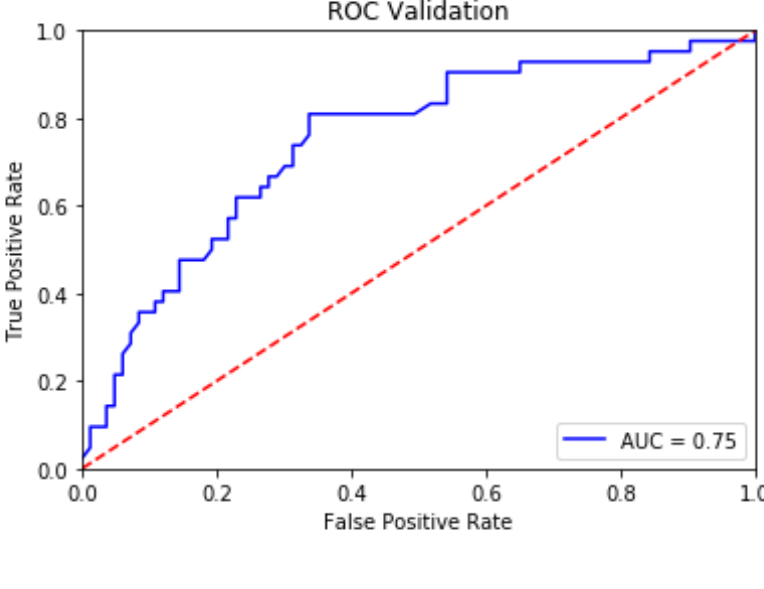
Figure 2. The receiver operating characteristic curve of E-RF. AUC: area under the curve; ROC: receiver operating